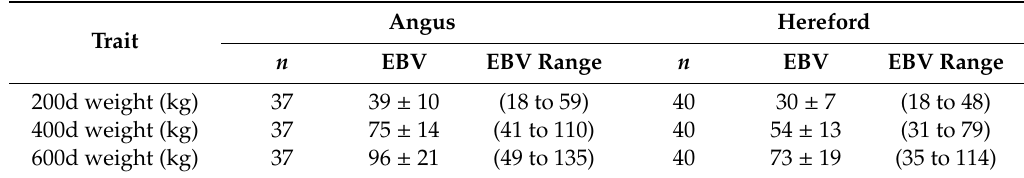
Table 1. Estimated breeding values (EBVs; mean ± SD) for live weights, at 200, 400 and 600 days of age, for 37 Angus and 40 Hereford sires